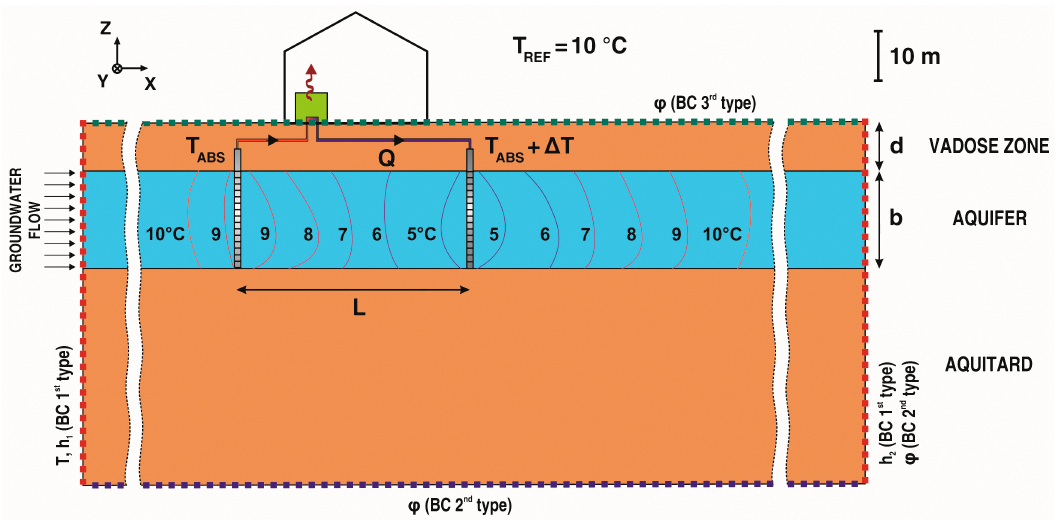
Figure 1. Simplified 2D cross-section of the GWHP plant 3D model in heating mode.